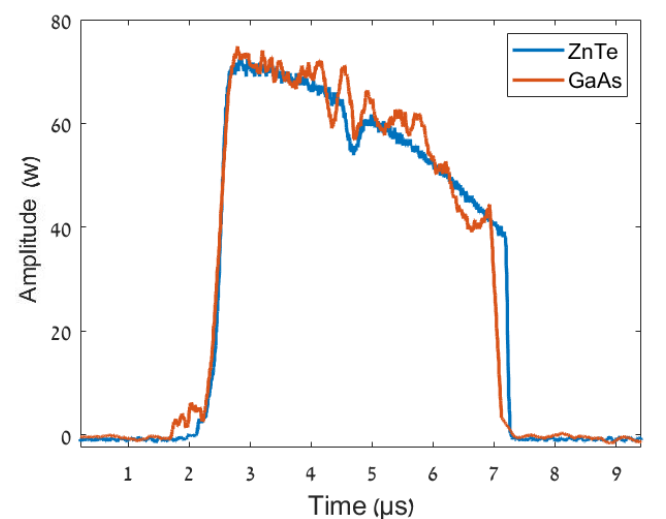
Figure 7. Low-power THz pulse detection by the electro-optic sampling using GaAs, ZnTe.